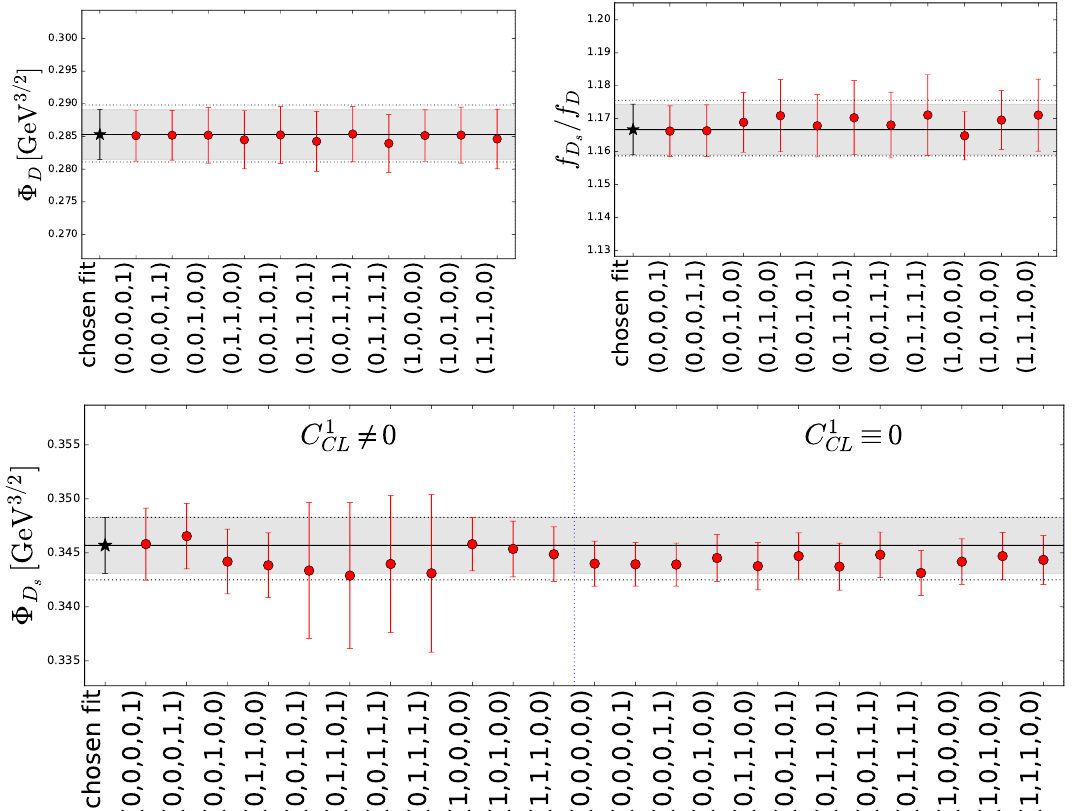
Figure 13 . Impact of di(cid:11)erent heavy mass cuts on the (cid:12)nal result of the (cid:12)t using equation (3.6). =f D (top right) and (cid:8) D The black star shows the chosen (cid:12)t for (cid:8) D (top left), f D for the preferred s s (cid:12)t as discussed above and highlighted by the vertical grey bands in (cid:12)gures 10 and 12. The grey band and grey dotted lines depict the statistical error and total (statistic and systematic error due to the (cid:12)t as presented in (3.7) and (3.8) added in quadrature), respectively. The red circles show the results of various mass cuts. The set of (cid:12)ve numbers label these cuts and correspond in order to the following: (including the am h = 0 : 45 point on C0; excluding the lightest charm mass point on all ensembles; excluding the lightest charm mass point on all coarse ensembles; excluding